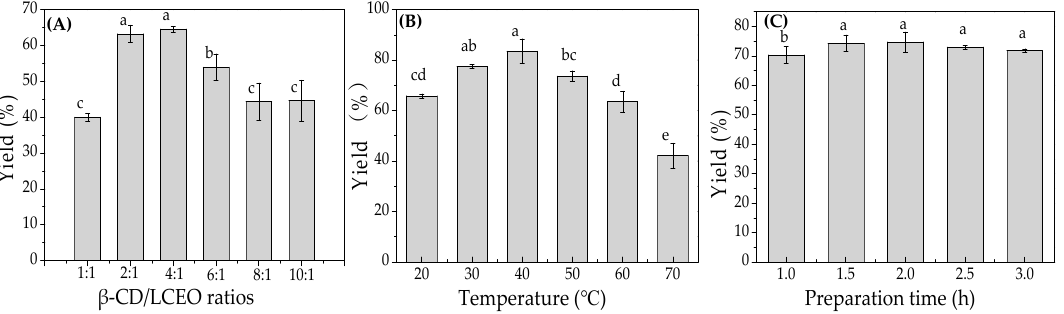
Figure 2. Effects of β -CD/LCEO ratios ( A ), temperature ( B ), and preparation time ( C ) on yield of Figure 2. E ff ects of β -CD / LCEO ratios ( A ), temperature ( B ), and preparation time ( C ) on yield of LCEO/ β -CD inclusion complex. LCEO / β -CD inclusion